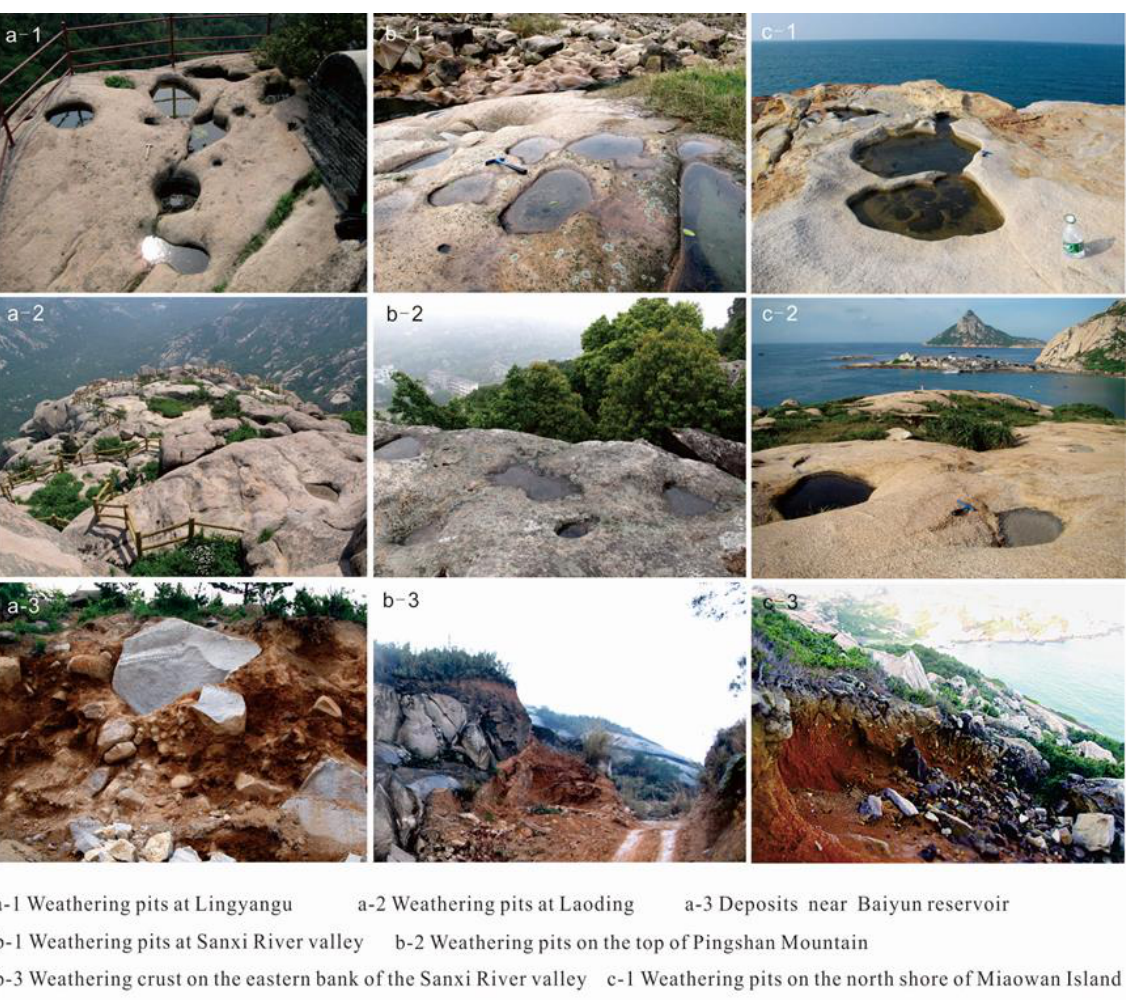
Figure 2. Weathering pits, weathering crusts and weathered deposits of the 3 study sites. ( a1 – a3 ) Study Site A, ( b1 – b3 ) Study Site B, ( c1 – c3 ) Study Site C. ( a1–a3 ) Study Site A, ( b1–b3 ) Study Site B, ( c1–c3 ) Study Site C. Study Site B. Pingshan Mountain (N25°50.193′, E119°32.429′) is a granite low moun- Study Site B. Pingshan Mountain (N25 ◦ 50.193 (cid:48) , E119 ◦ 32.429 (cid:48) ) is a granite low